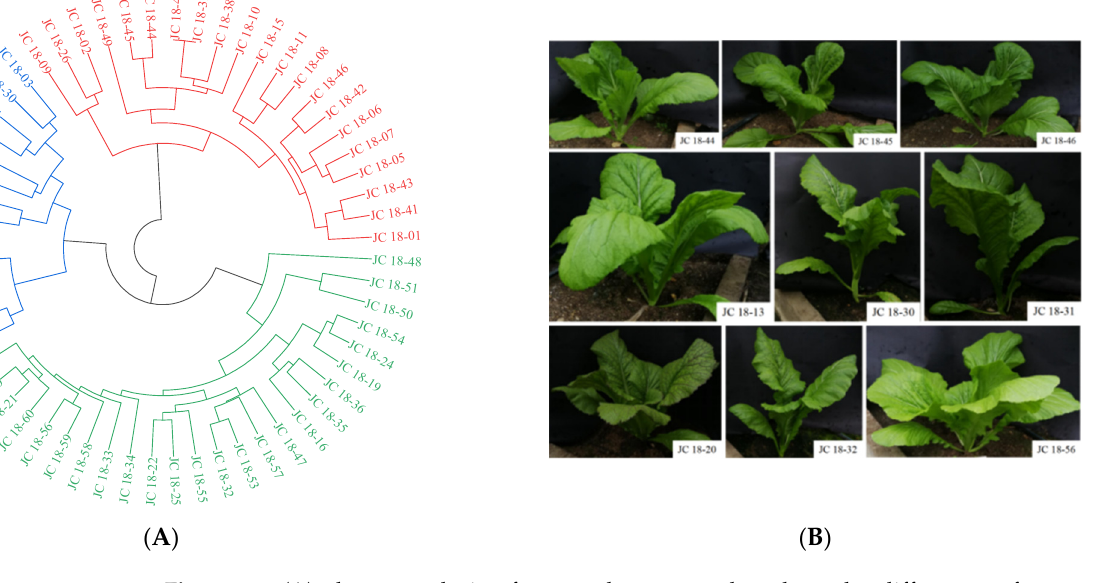
Figure 5. ( A ) cluster analysis of mustard resources based on the different performances of 30 agronomic traits. The distance matrix was grouped using the unweighted pair-group method with arithmetic mean after the Euclidean distance coefficients among the columns of the data matrix were calculated. The tested materials were clustered into three groups at the genetic distance of 56.7; and ( B ) morphological characteristics of some mustard resources.